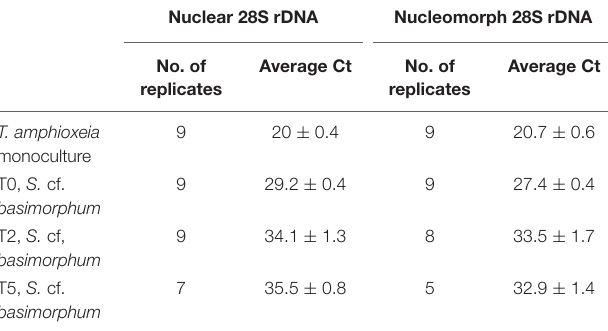
TABLE 1 | Average cycle threshold (Ct) values for prey nuclear and nucleomorph 28S genes in qPCR assays conducted on prey DNA ( T. amphioxeia monoculture) and DNA extracted from the ciliate ( S. cf. basimorphum ) at different time points (corresponding to different nutritional stages of the ciliate